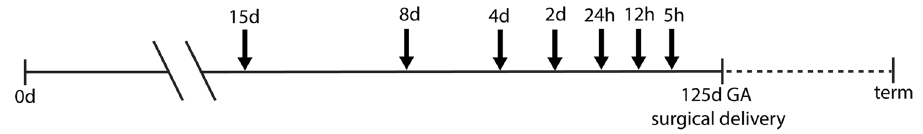
Figure 1. Study design. At 5, 12, or 24 hours or 2, 4, 8 or 15 days (black arrows) pregnant ewes received an IA injection with 10 mg LPS before preterm delivery at 125 days of gestation (term ~ 150 days). An IA